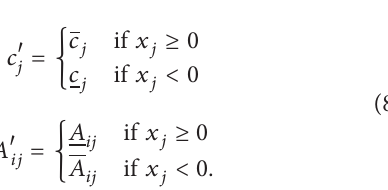
Figure 2: A floating-point program piecewise linear